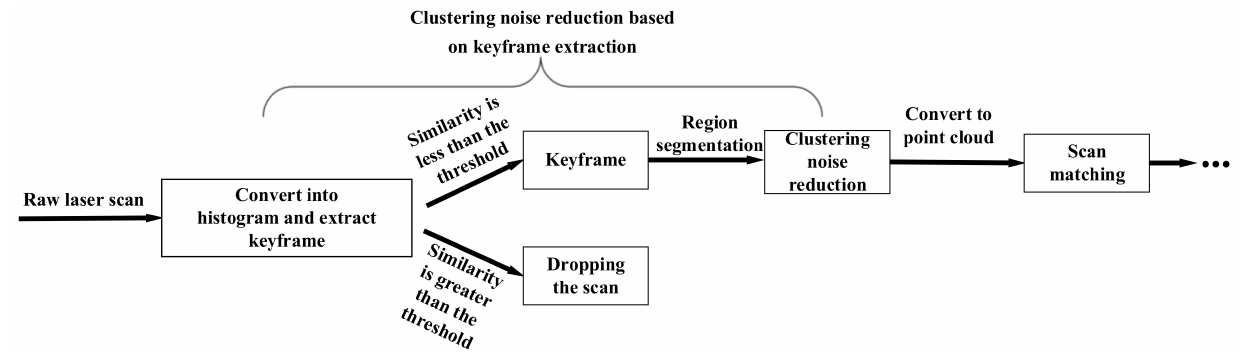
Figure 1. The process framework of the method and its position in the SLAM system. The method will be inserted into the SLAM system where it was before converting the 2D LiDAR data to the point cloud